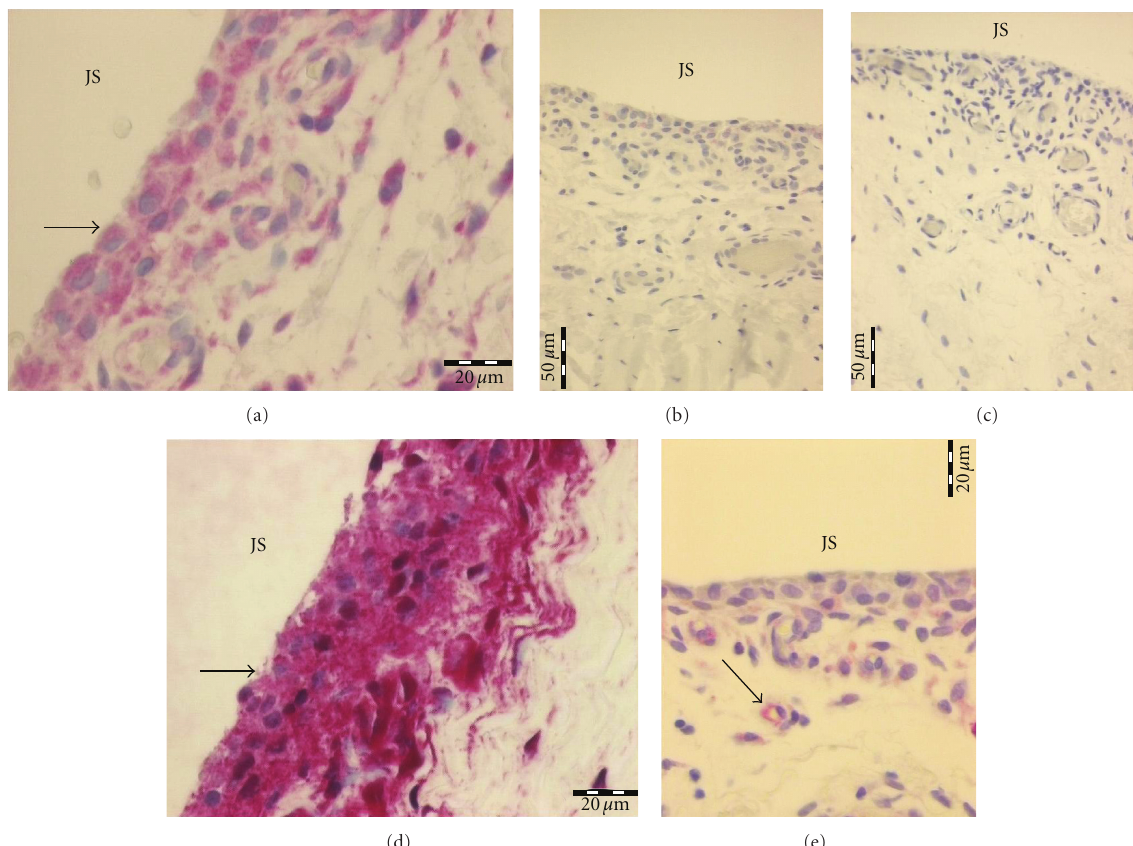
Figure 3: Immunostaining of synovia, positive staining (arrows) is indicated by the red color mainly located around the nucleus of chondrocytes, (a) BMPR-1A (summary score 6), (b) BMPR-1B (summary score 1), (c) BMPR-2 (summary score 1), (d) BMP-7 (summary score 6), (e) BMP-2 (summary score